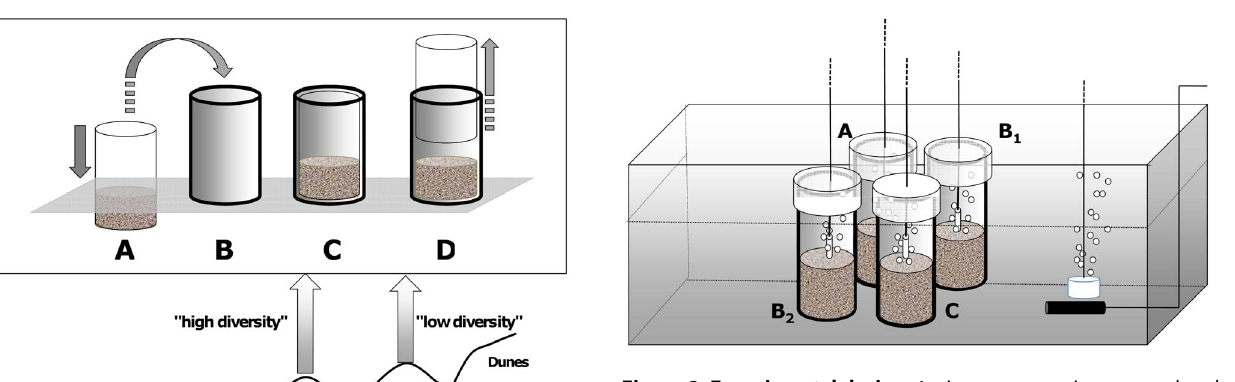
Figure 2. Experimental design . 4 microcosm containers were placed in each of 10 tubs. The time 0 control (A) was analyzed at the start of the experimental treatment when temperature was changed in the high temperature treatments. The experimental groups of high (B 1 ) and low (B 2 ) diversity were kept at constant temperature throughout the experiment: elevated (36 u C) for the test group and normal (31 u C) for the "temperature control" group. Each experimental group was replicated 5 times. The live control (C) was used to monitor nematodes throughout the experiment.